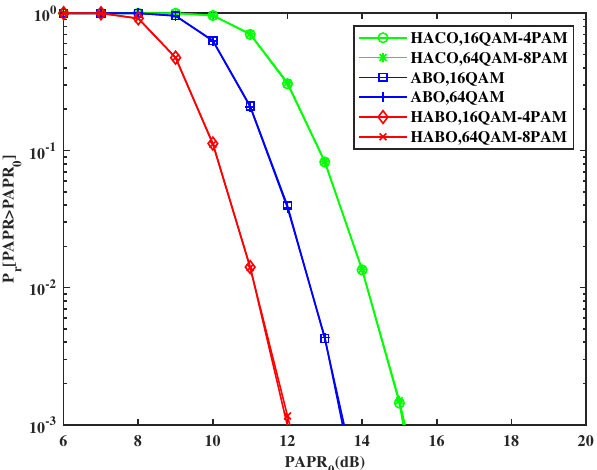
Figure 4. CCDF curves of the PAPR for HACO-OFDM, ABO-OFDM, and HABO-OFDM.